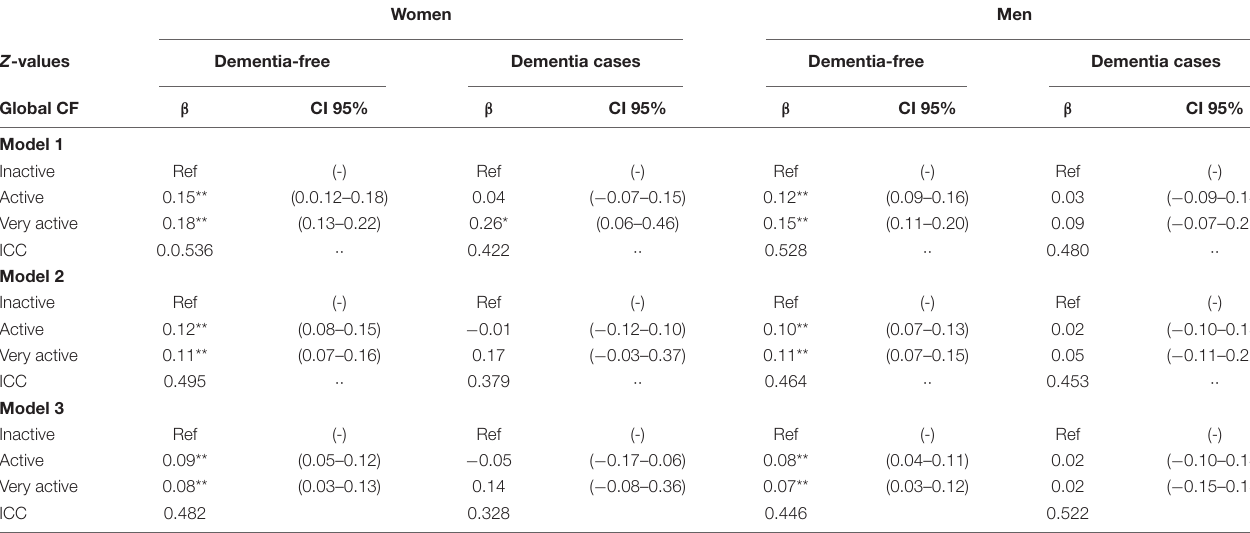
TABLE 2 | Effect of PA on global cognitive score, mixed effects